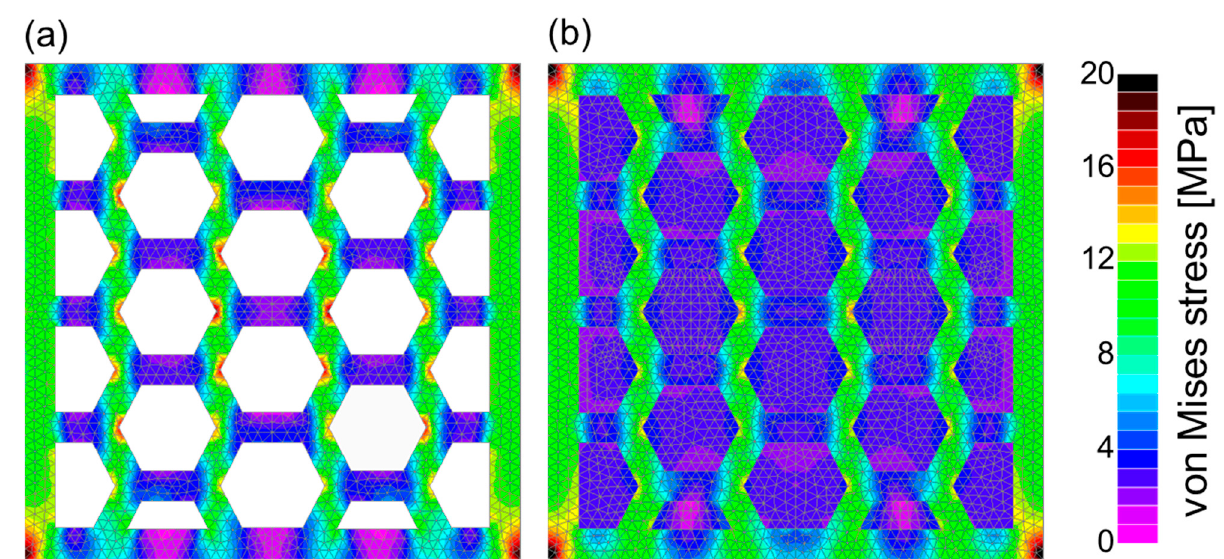
Figure 7. von Misses stress distribution for ( a ) porous and ( b ) composite structure.